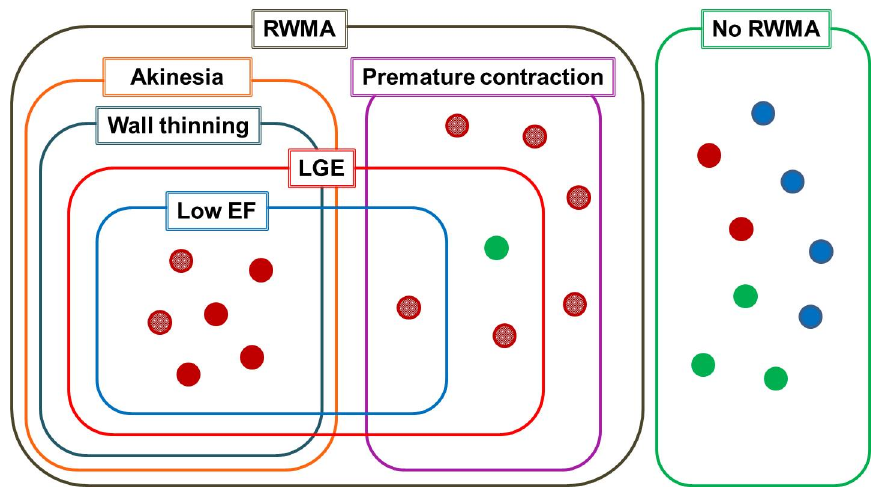
Fig 3. Set diagram for the logical relations between the major findings. Red circles indicate patients with septal accessory pathways, green circles indicate right accessory pathways and blue circles indicate left accessory pathways. Patterns within the circles indicate patients who did not undergo radiofrequency ablation. EF = ejection fraction; LGE = late gadolinium enhancement; RWMA = regional wall motion